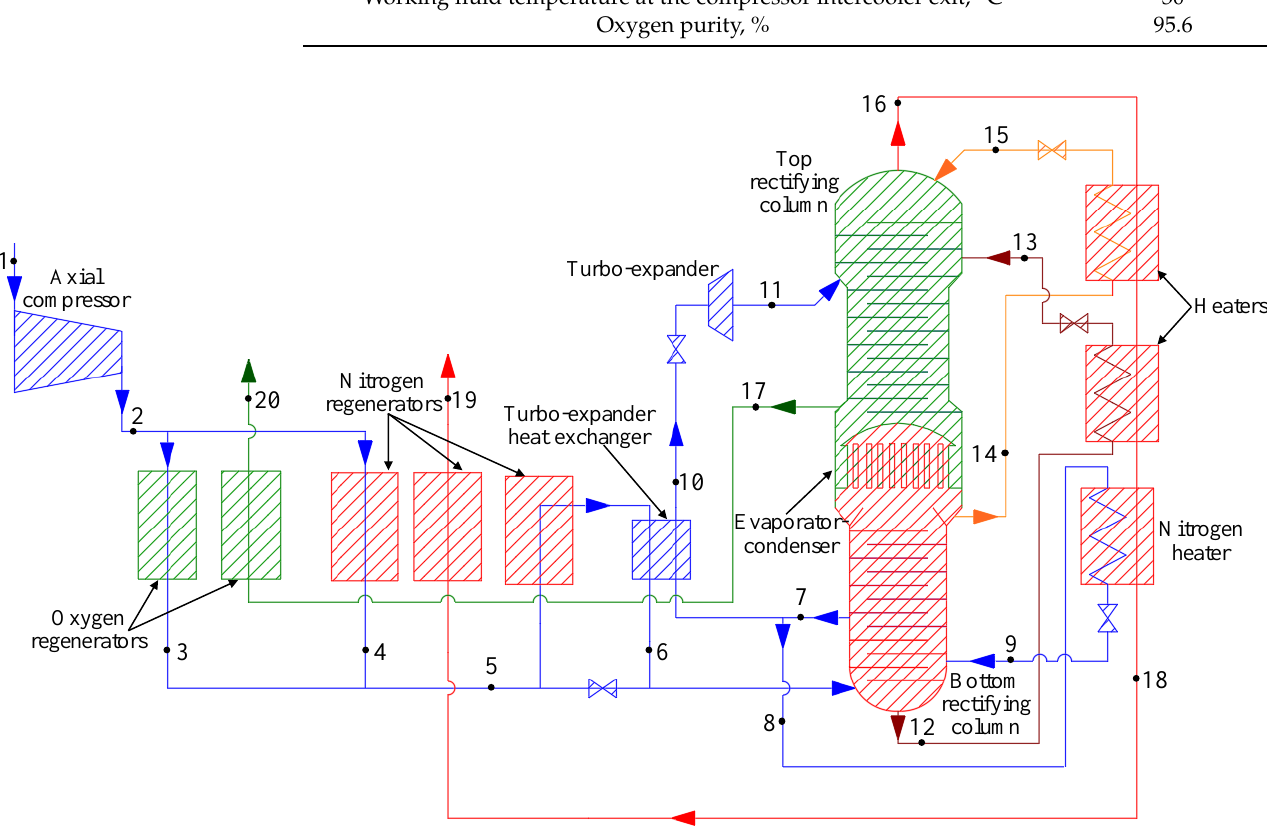
Figure 2. The low-pressure ASU. Table 2. ASU flow parameters.